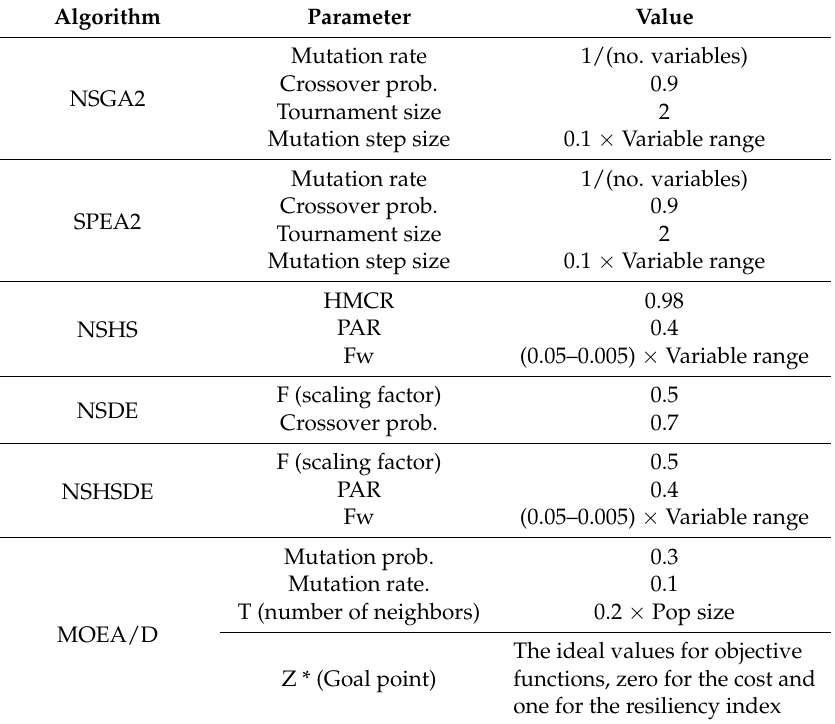
Table 7. Parameters used in multi-objective evolutionary algorithms